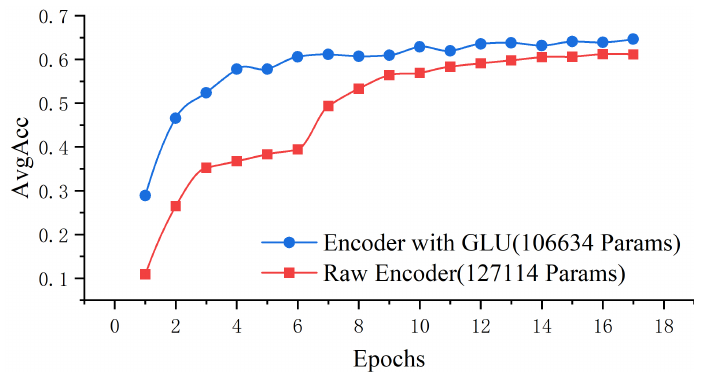
Figure 8. Average accuracy of the improved Encoder vs. the original encoder on the validation set for each epoch in the training